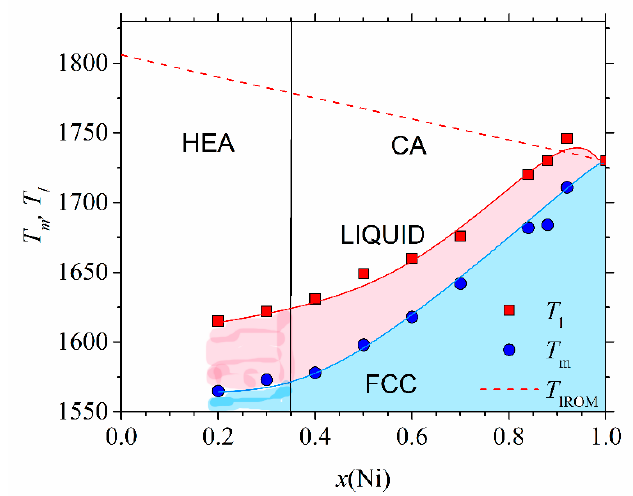
Figure 5. High-temperature phase diagram of (CrMnFeCo) 1 − x Ni x alloys. The region of coexistence of a solid and a liquid is colored magenta. The red dashed line denotes variation of T m calculated using the rule of mixtures.